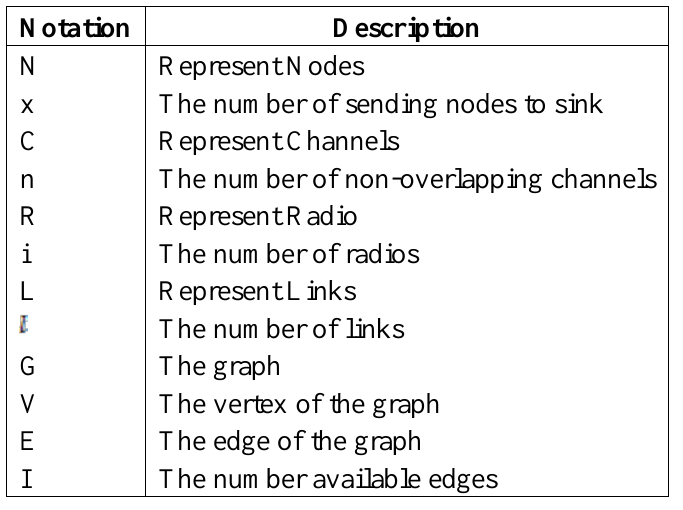
Table 1. Notation